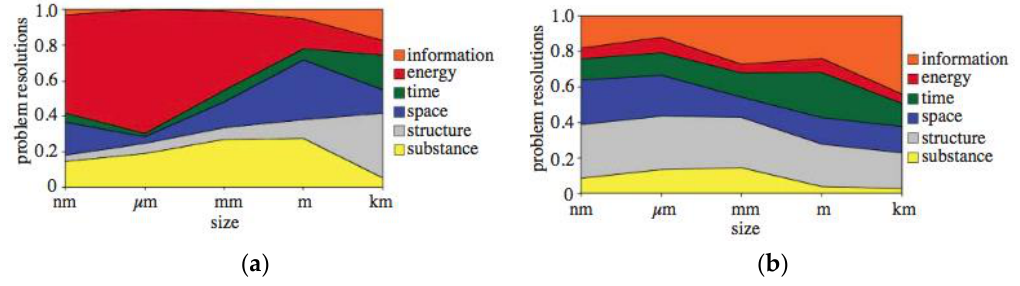
Figure 2. ( a ) The types of problem-solving strategies that human technology employs on different length scales [26]. Technology tends to function by manipulating energy and substance; ( b ) Types of effects observed in biology at different length scales [26]. Natural systems tend to function on account of how they are structured and the way information is managed.